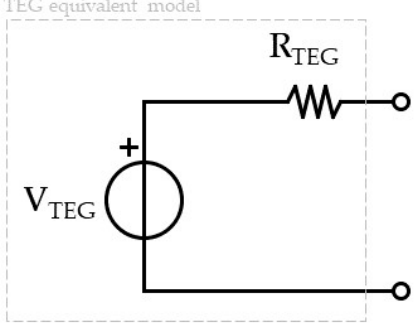
Figure 3. Adopted electrical description of the TEG cell.